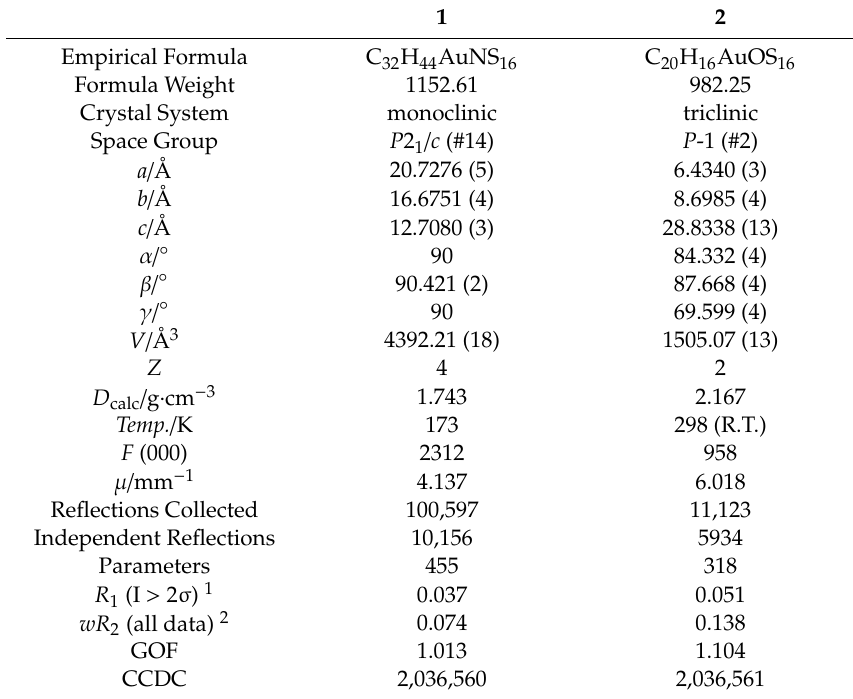
Table 1. X-ray crystallographic data of the gold complexes 1 and 2